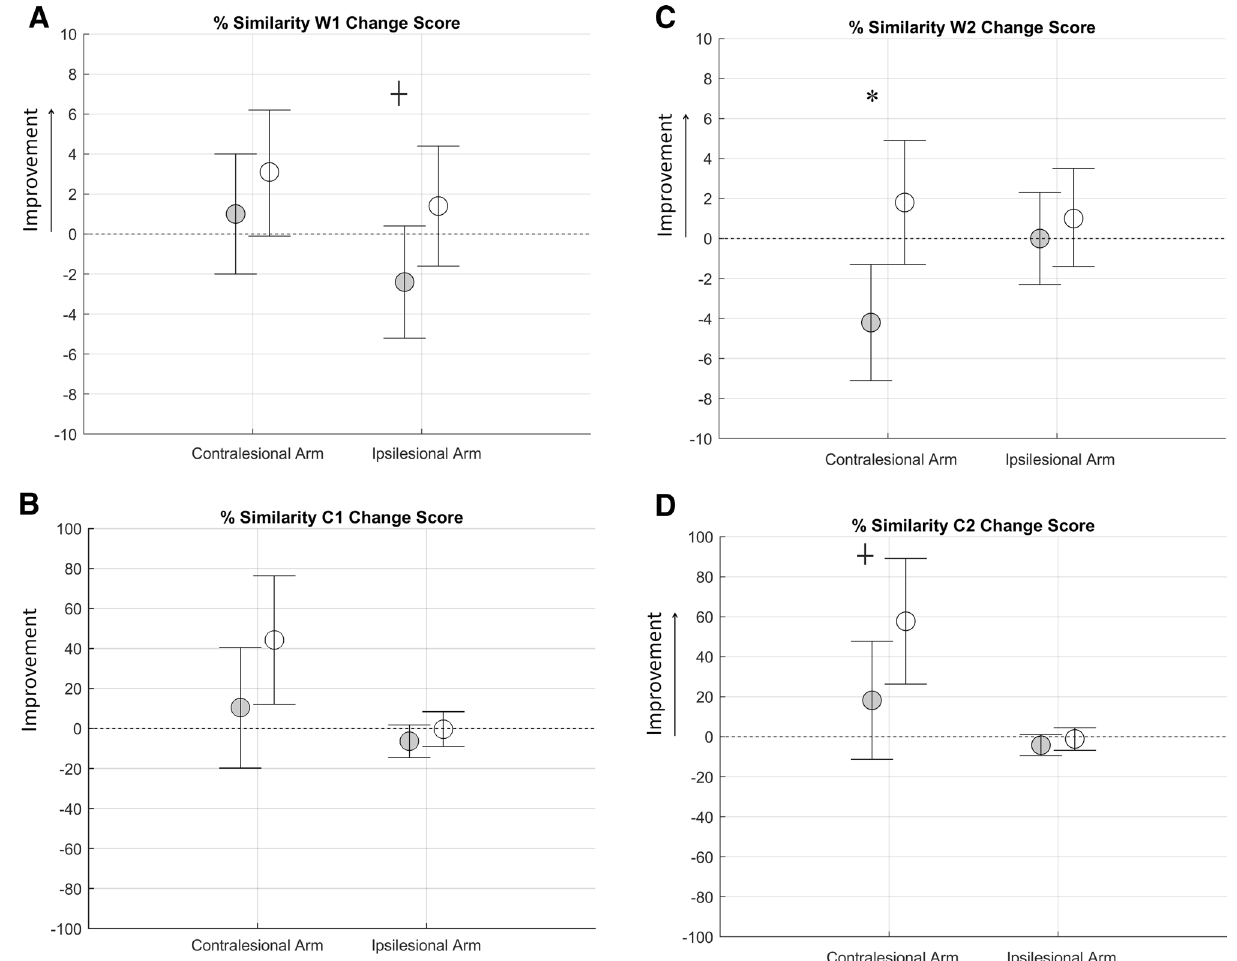
Figure 3. Pre to post change scores from baseline attained by post-stroke participants after robot therapy (RG, white circles) and usual care intervention (UCG, gray circles) during the object placing task for muscle weightings (top panels) and activation profiles (bottom panels) of synergy 1 ( B – D ) and 2 ( C – E ). Circles and whiskers represent, respectively, mean change score and 95% confidence interval adjusted for baseline score through ANCOVA procedure. * P < 0.05 (RG vs. UCG, ANCOVA test). + 0.05 ≤ P < 0.1 (RG vs UCG, ANCOVA